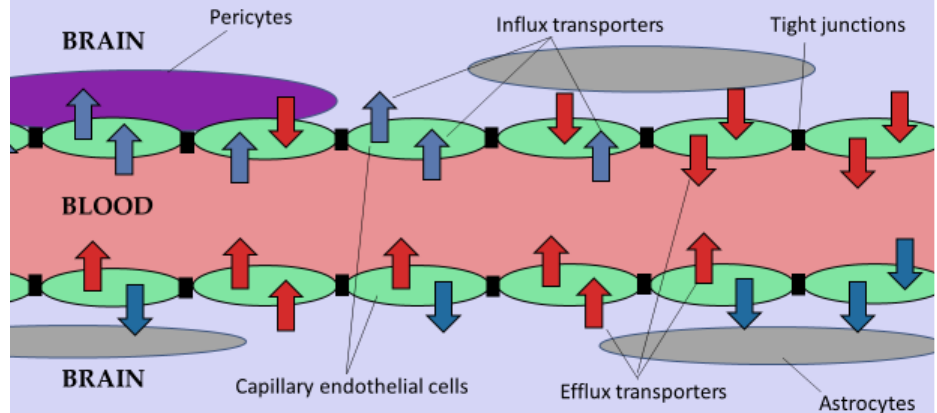
Figure 1. The blood-brain barrier and drug transporters in the capillary endothelial cells. (Blue arrows: Flow of molecules through influx transporters into the brain parenchyma from the blood vessel; Red arrows: Outward flow of molecules through efflux transporters from the brain parenchyma to the blood vessel) [Adapted from [17] in terms of the Creative Commons Attribution License (CC BY 3.0)].